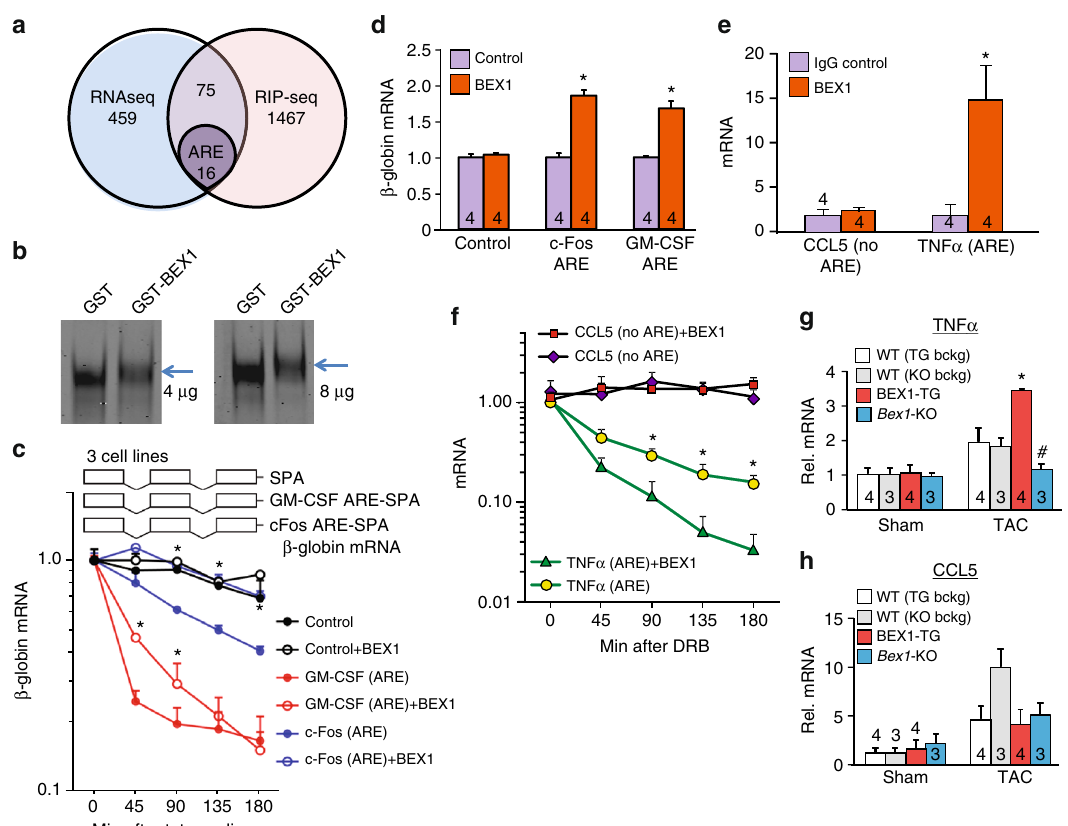
Fig. 5 BEX1 directly controls A + U-rich element containing mRNAs. a Comparison of RNAseq and RIP-seq list showing 91 overlapping mRNAs due to BEX1 overexpression or BEX1-dependent pull-down, respectively, 17.58% of which contains AU-rich elements (ARE). b RNA EMSA showing an ARE- ribonucleoprotein cardiac complex shift from heart protein extract at 4 and 8 μ g, which is shifted even higher by addition or recombinant BEX1-GST (blue arrows). GST was used as negative control. c qPCR for β -globin mRNA at 0, 45, 90, 135 and 180 min post-tetracycline addition in stable cell lines (control, GM-CSF ARE or c-fos ARE) transfected with BEX1 or GFP control plasmid. A synthetic poly A (SPA) is present in all 3 constructs. Results re fl ect 3 separate experiments. d Level of β -globin mRNA following RNA immunoprecipitation using Flag antibodies from Flag-BEX1 or GFP expressing stable cell lines (control, GM-CSF ARE and c-fos ARE) by qPCR. The results are from 3 separate experiments. e qPCR analysis for TNF α and CCL5 mRNA immunoprecipitated with BEX1 antibody from BEX1 transgenic hearts. Number of experiments conducted is shown in the graph for each condition. * P < cardiomyocytes infected with BEX1 or β -galactosidase control adenoviruses. The average from 3 independent experiments is shown. g , h qPCR analysis of Bckg = strain background. Number of hearts analyzed is shown in the graph for each condition. * P < 0.05 vs. WT (TG bckg) TAC mRNA. # P < 0.05 vs. WT (KO bckg) TAC mRNA. For all other panels * P < 0.05 vs. ctrl. All error bars represent s.e.m. All P values are unpaired 2-tailed t test for this fi